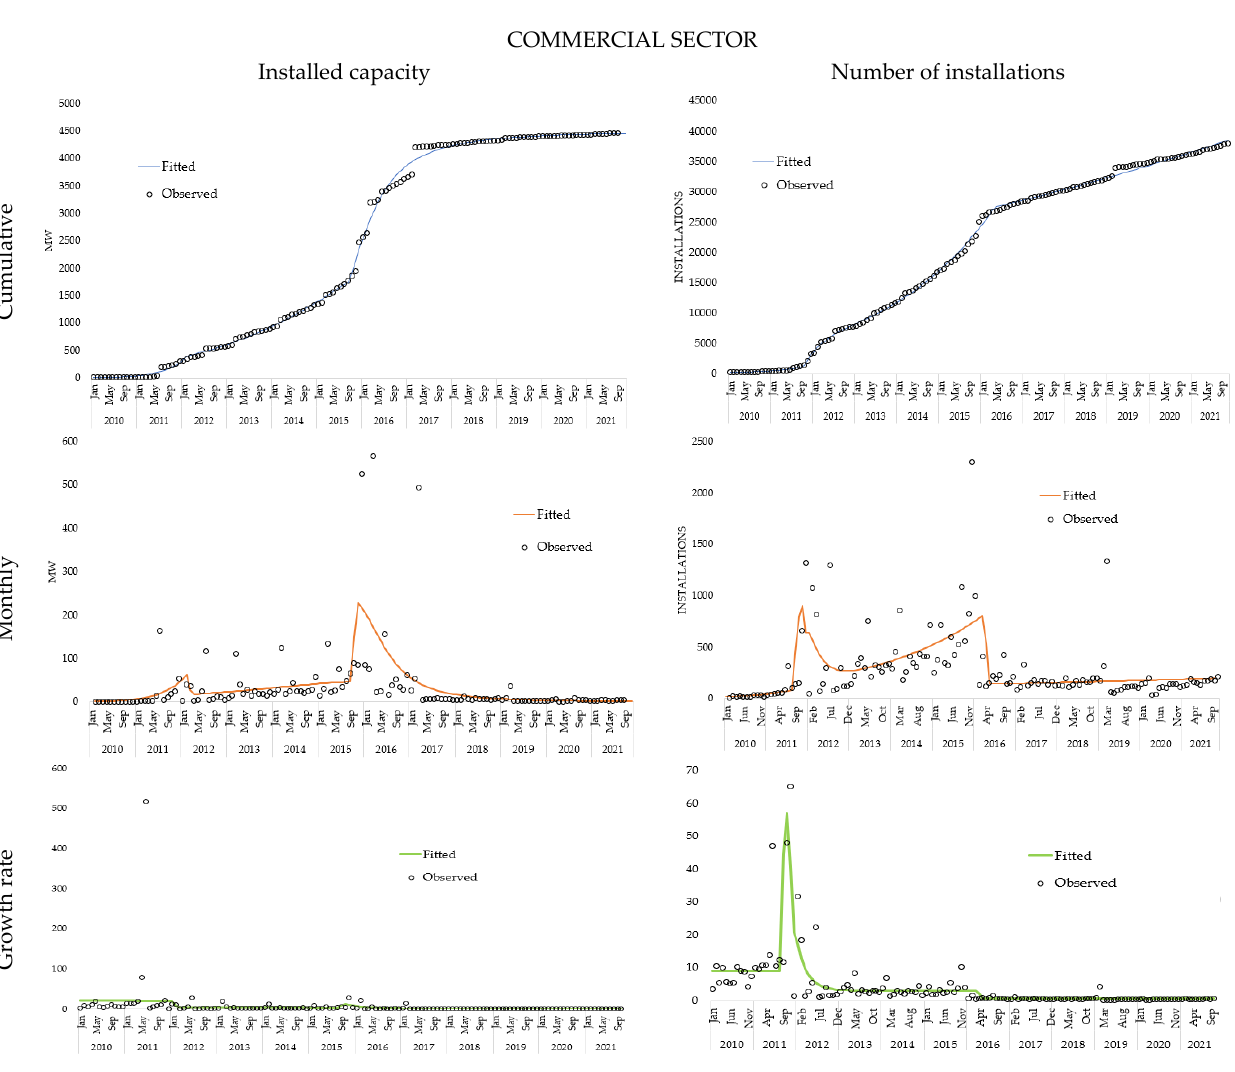
Figure 5. Observed vs. fitted (by the best GIM model) PV adoptions in the UK 2010 – 2021 for the commercial sector by installed capacity and by numbers of installations. For each category considered, the figure reports: (i) cumulative adoptions, (ii) monthly adoptions, and (iii) growth rate of cumulative adoptions.